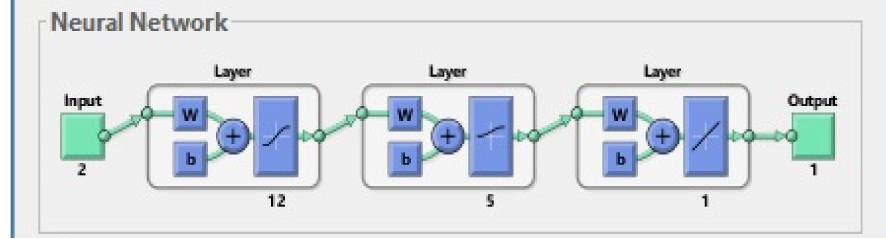
Fig. 4 Design of traditional Artificial Neural